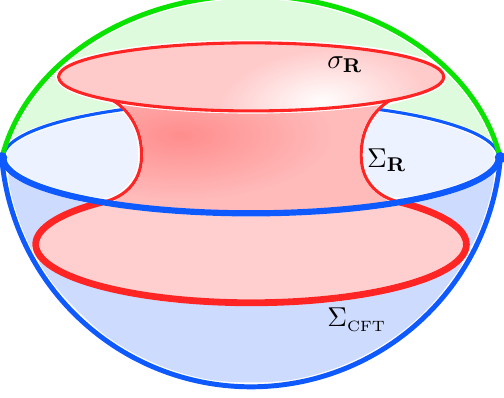
Figure 7 . A timeslice of AdS d +1 space. The entangling surface (cid:6) and the RT surface (cid:6) R intersects the brane at (cid:27) R